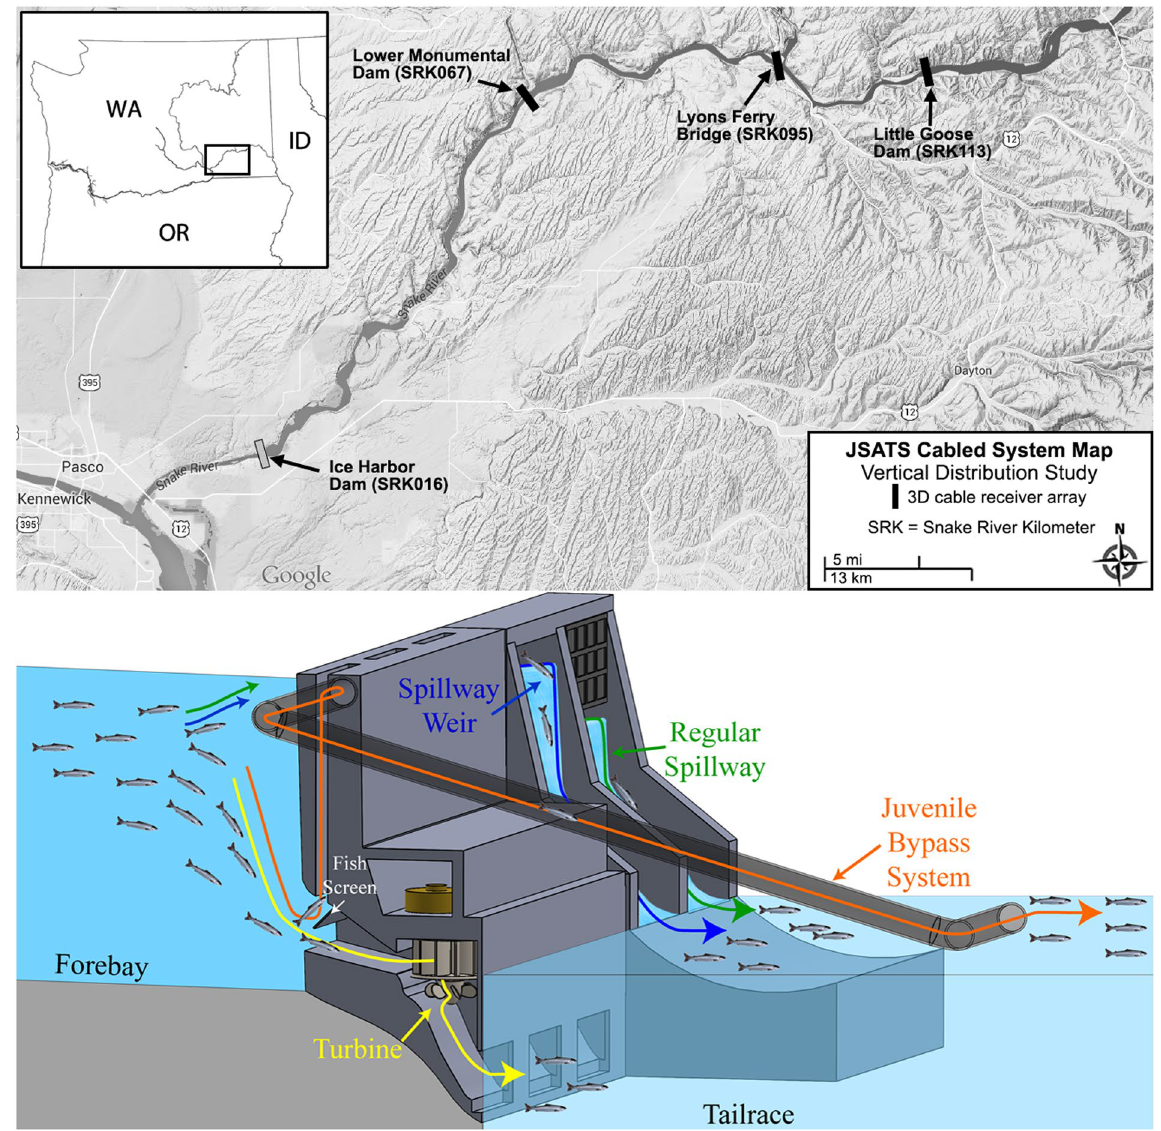
Figure 1. (Top) Locations of JSTAS-Cabled Hydrophone Arrays on the Snake River (Little Goode Dam, Lyons Ferry Bridge and Lower Monumental Dam) in Washington State, USA (the source of the map is Google Maps); (Bottom) A schematic diagram (created referring to NOAA Fisheries West Coast Region 44 ) from of the four passages routes at Little Goode Dam and Lower Monumental